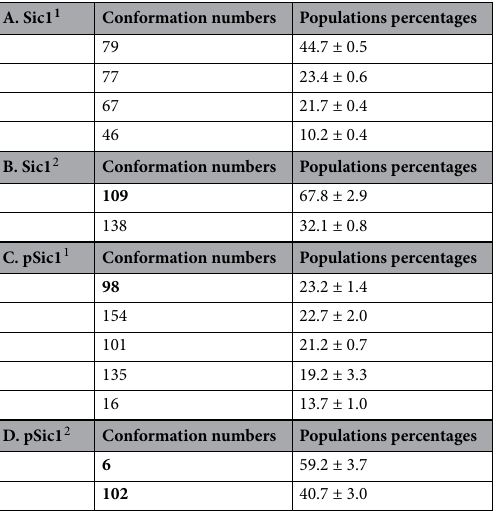
Table 3. Conformations and populations selected by fitting of the Ramachandran maps using RamaMix. For each set of protein conformations, 100 runs were performed starting from random values for the populations. The few converged optimizations which did not converge, were discarded: 6 for Sic1 1 2 pSic1 and 3 for pSic1 . The backbone angles φ and ψ were allowed to move up to 15 ◦ . The populations of conformations for the converged runs were averaged and these mean values are given as percentages in the Table along with the corresponding standard deviation values. The labels of conformations also selected by BioEn are written in